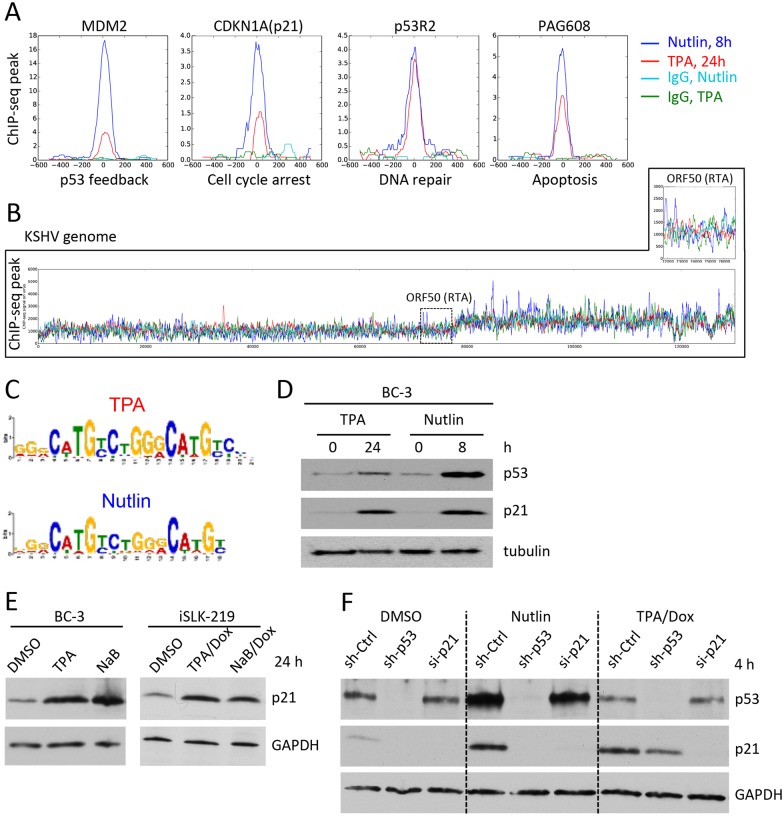
Viral reactivation leads to a p53 response in PEL cells.(A) BC-3 cells treated with TPA (red line) or Nutlin (blue line) for indicated times were processed for ChIP-seq analysis using an antibody against p53. Each chart represents the sequencing signal (ChIP-seq peak) obtained after immunoprecipitation with the p53 (blue and red lines) or nonspecific IgG antibodies (light blue and green lines) for the indicated cellular genes. The known function of each gene is indicated at the bottom of each panel. (B) The sequencing signal of BC-3 cells treated as in (A) is shown for the whole KSHV genome. The inset is an enlarged view of the DNA region coding for the RTA gene (black dashed box). (C) Using the MEME software, the same consensus binding-motif of p53 was identified de novo from the ChIP-seq results of BC-3 cells treated with Nutlin (8 h) or TPA (24 h). (D) BC-3 cells were treated with TPA for or Nutlin for indicated times and processed for WB using antibodies against p53, p21 and tubulin. (E) BC-3 or iSLK.219 cells treated with vehicle (DMSO) or indicated inducers for 24 h were processed for WB using antibodies against p21 and GAPDH. (F) iSLK.219 cells were treated with indicated sh- or siRNAs for 48 h and then incubated with DMSO, Nutlin or TPA/Dox for 4 h before WB analysis using antibodies against p53, p21 and GAPDH.